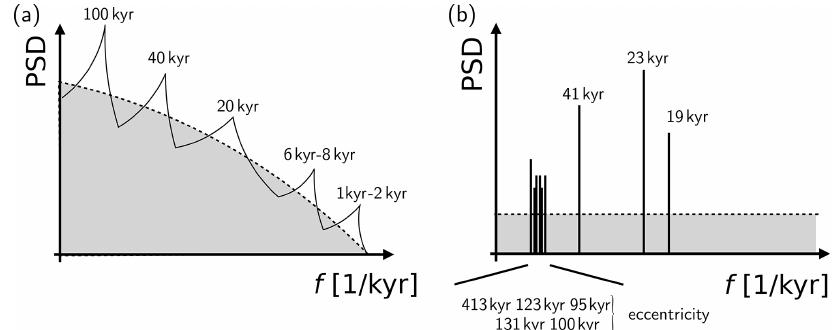
Figure 3. The theoretical quandary of modeling the Quaternary glaciation cycles, illustrated here by schematic diagrams of the composite power spectral densities (PSD) of (a) the paleo-records and (b) the orbital forcing. In panel (a) , the dominant peak for the Late Pleistocene is near 100kyr, while in panel (b) eccentricity forcing is distributed over several spectral lines. The peaks at 6–8 and 1–2kyr in panel (a) correspond to Bond cycles (Bond et al., 1992, 1993) and to the mean recurrence of D-O events, and they lack a match in the forcing lines of panel (b)